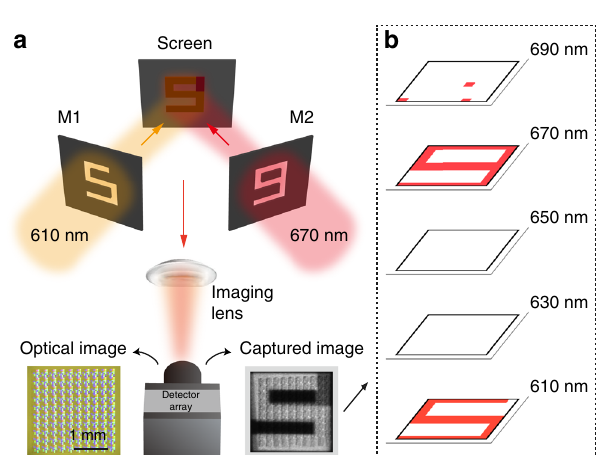
Fig. 5 Hyperspectral imaging using the PC spectrometer. a Measurement set- up. The imaging target is a mix of the numbers “ 5 ” and “ 9 ” , with the “ 5 ” comprising light incident on the screen at 610±5nm and the “ 9 ” comprising light at 670±0.7nm. The spectral information of this target is then obtained via a single snapshot using our device. The optical and captured images are shown on the left and right of the device, respectively. M, mask. b Spatial maps from the reconstructed data cube at 610, 630, 650, 670, and 690nm, respectively